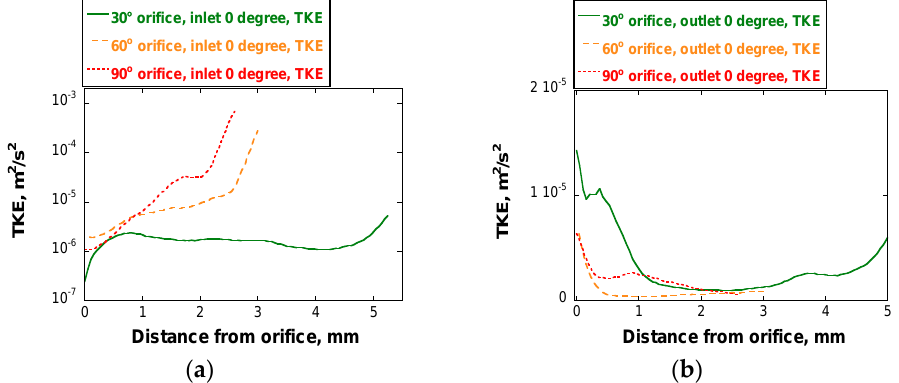
Figure 14. Schematics of inlet orifices with different angles. Note that only the outlet orifices are shown. shown. shown. not shown.